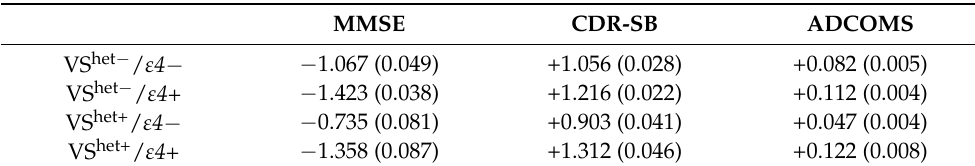
Table 4. Averaged annualized rates of cognitive decline along with standard error given in parenthesis in participants grouped via cross-classification by KL- VS het and APOE ε 4 status. Rates of yearly cognitive decline are derived from a multiple linear regression model.